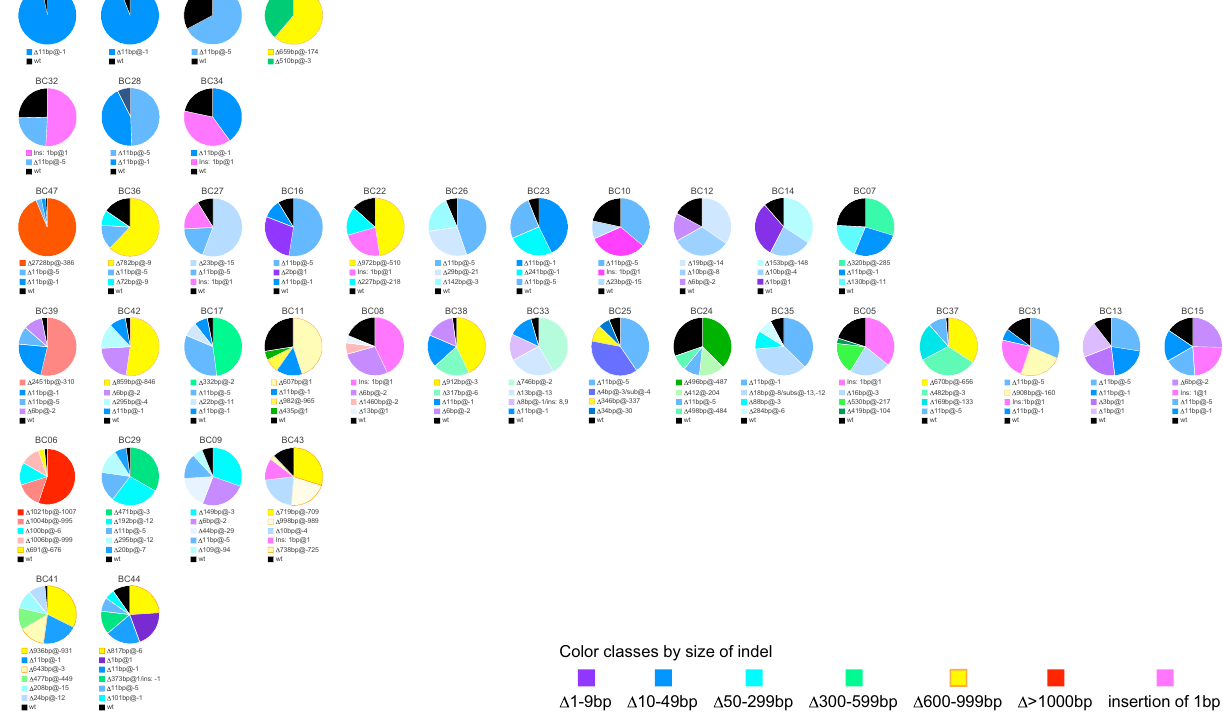
Figure 8. Representation of T/brachyury allele sequences within each individual. Colored segments depict the fraction of each edited allele among all sequences for the respective sample; wildtype sequences are indicated by black color. The color scheme corresponds to the same deletion size classes as defined in Fig. 7. Size of each INDEL (as listed in Table 1) is given in the legend below each sample. Samples are ordered by the total number of alleles detected (edited and wildtype), with individuals harboring 2 alleles at the top, and those with the most alleles at the bottom of the figure. Within each allele class, samples are ordered from left to right according to descending proportion of the most prominent edited